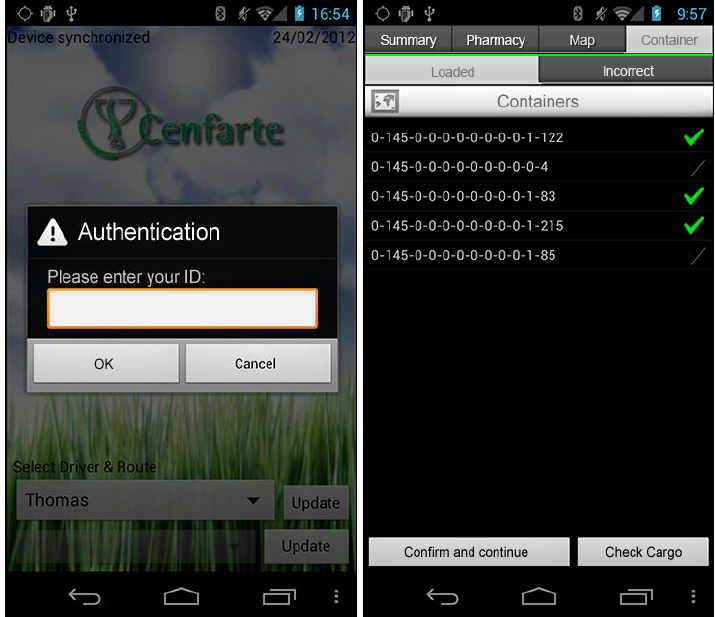
Figure 11. Developed mobile application